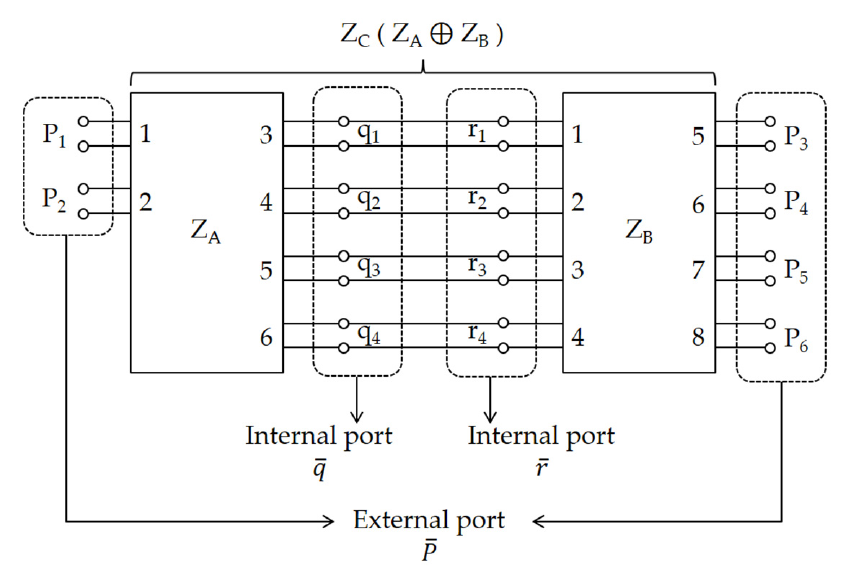
Figure 4. Impedance block diagram for determining the recombination impedance parameters of domain decomposition method (DDM) segments A and B.